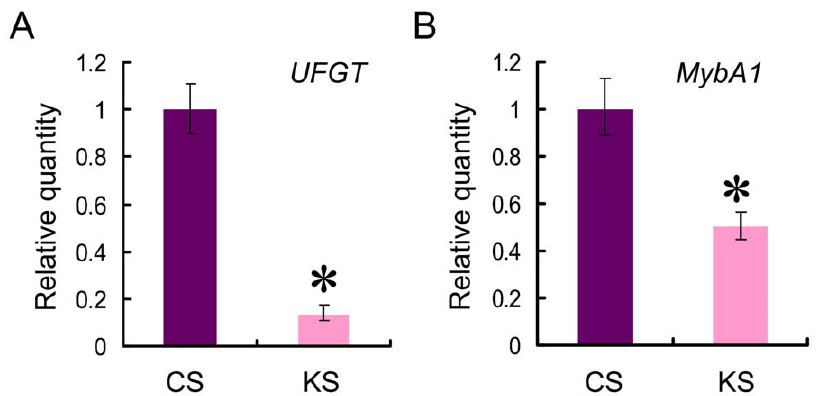
Figure 2. UFGT and MybA1 gene expression in Koshu grape berry skin. (A) UFGT . (B) MybA1 . CS, Cabernet Sauvignon. KS, Koshu. *p , 0.01 as compared with CS.